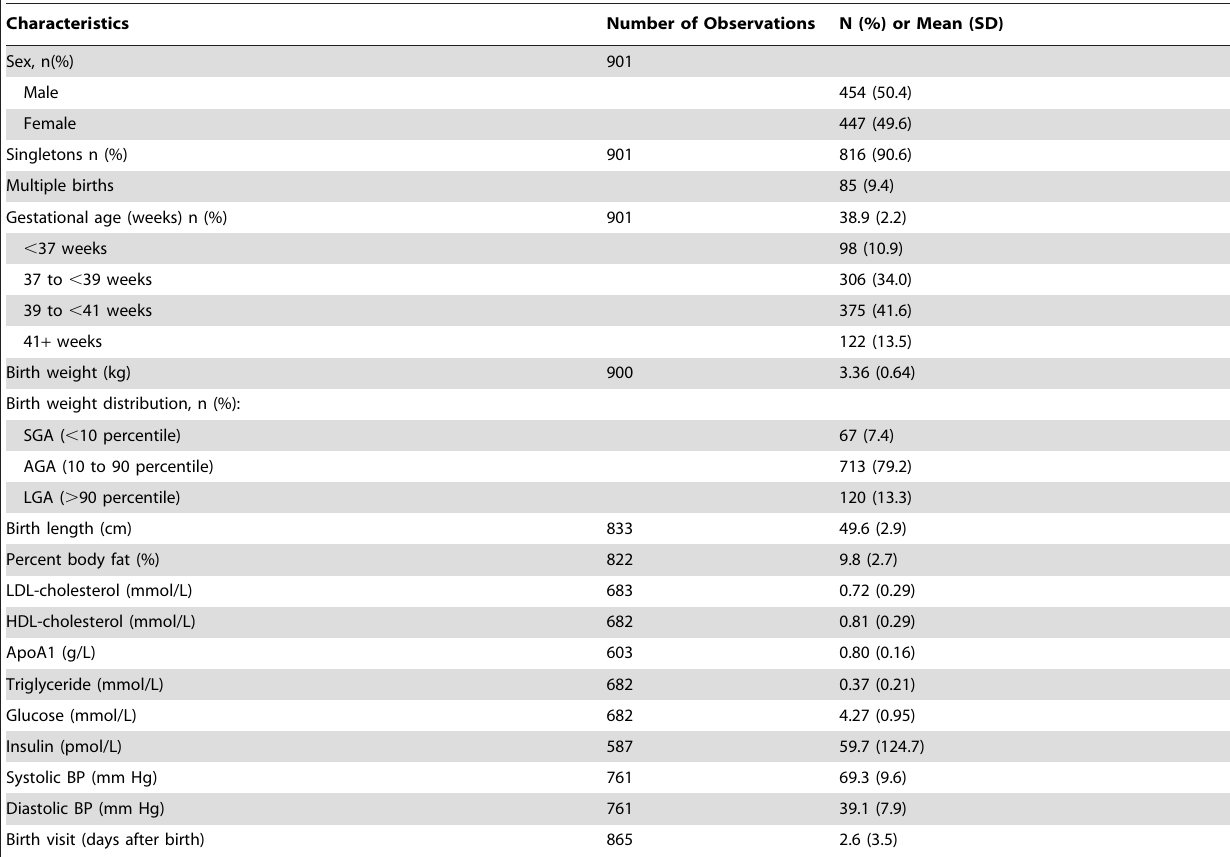
Characteristics